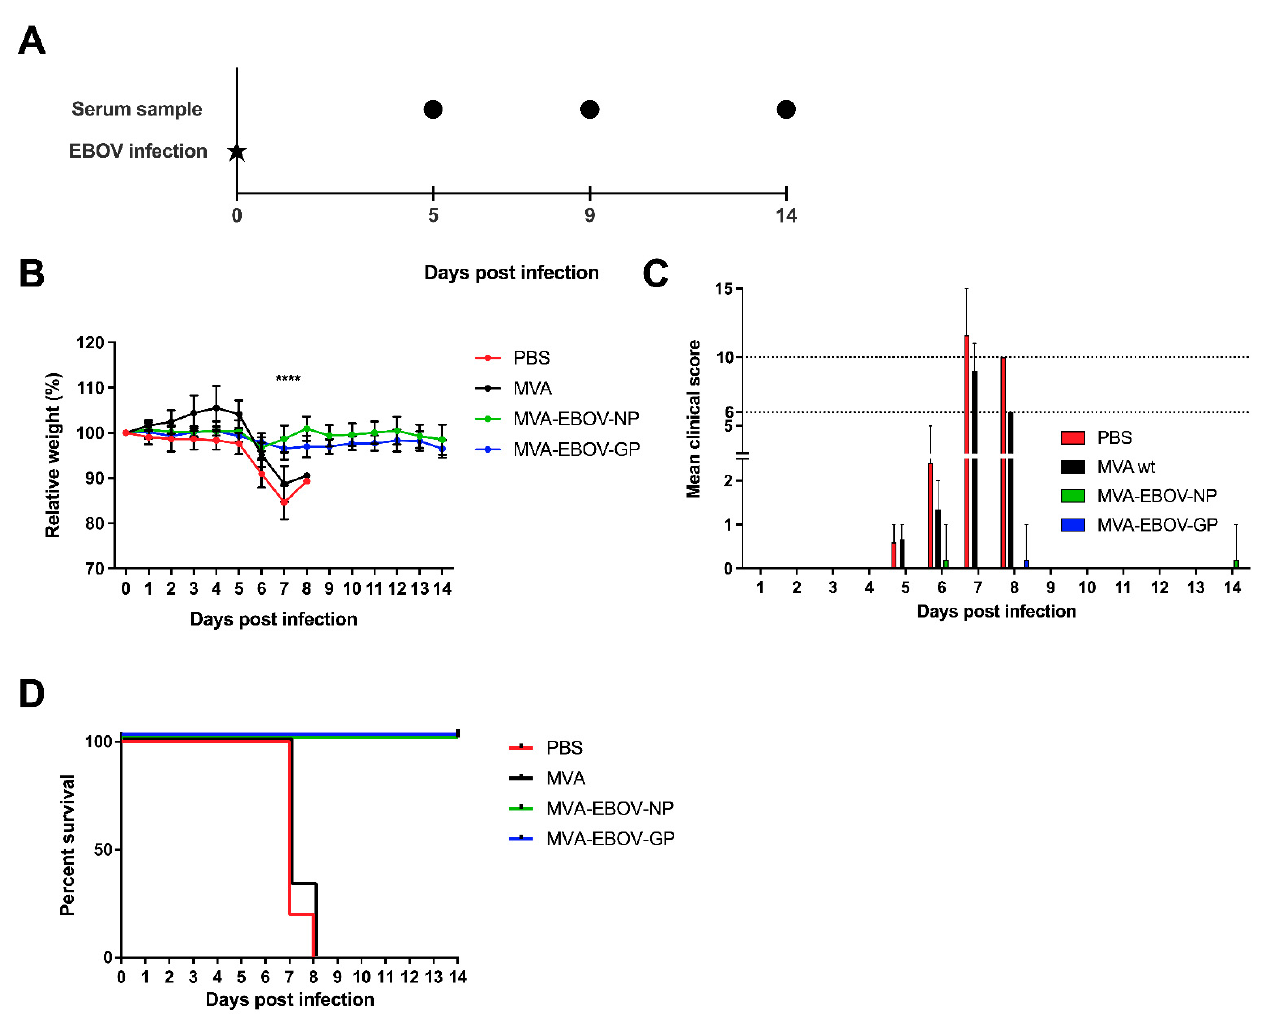
Figure 3. MVA-EBOV protection against EBOV infection. ( A ) Vaccinated IFNAR -/- mice were challenged by intranasal inoculation with 1000 PFU EBOV (Mayinga isolate) 65 days after primary vaccination; PBS, MVA-EBOV-GP, MVA-EBOV-NP: n = 5 mice, MVA: n = 3 mice. Serum samples were obtained at the indicated time points post EBOV infection. ( B ) Mean relative body weight changes post challenge; error bars: standard deviation; **** p < 0.0001. ( C ) Mean clinical score comprising body weight, general condition and spontaneous behavior (see Material and Methods; Table S1). The clinical end point was defined as an individual score of 10 or of 6 on two consecutive days (dotted lines); error bars: maximum score. ( D ) Kaplan–Meier survival curves.